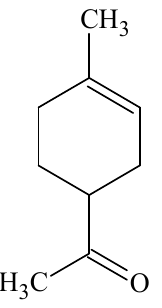
Figure 3. Chemical structure of